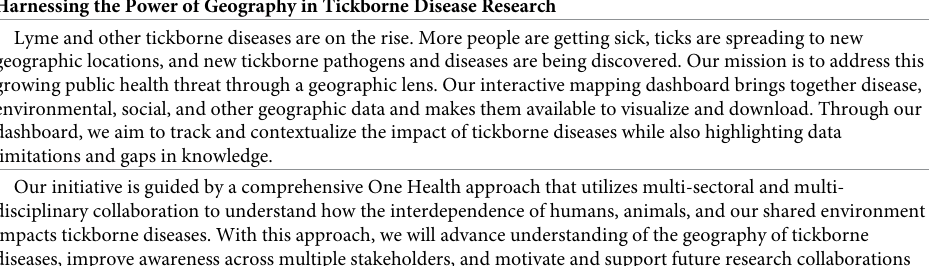
Table 1. Mission statement of the Johns Hopkins Lyme and Tickborne disease dashboard. Harnessing the Power of Geography in Tickborne Disease Research Lyme and other tickborne diseases are on the rise. More people are getting sick, ticks are spreading to new geographic locations, and new tickborne pathogens and diseases are being discovered. Our mission is to address this growing public health threat through a geographic lens. Our interactive mapping dashboard brings together disease, environmental, social, and other geographic data and makes them available to visualize and download. Through our dashboard, we aim to track and contextualize the impact of tickborne diseases while also highlighting data limitations and gaps in knowledge. Our initiative is guided by a comprehensive One Health approach that utilizes multi-sectoral and multi- disciplinary collaboration to understand how the interdependence of humans, animals, and our shared environment impacts tickborne diseases. With this approach, we will advance understanding of the geography of tickborne diseases, improve awareness across multiple stakeholders, and motivate and support future research collaborations and